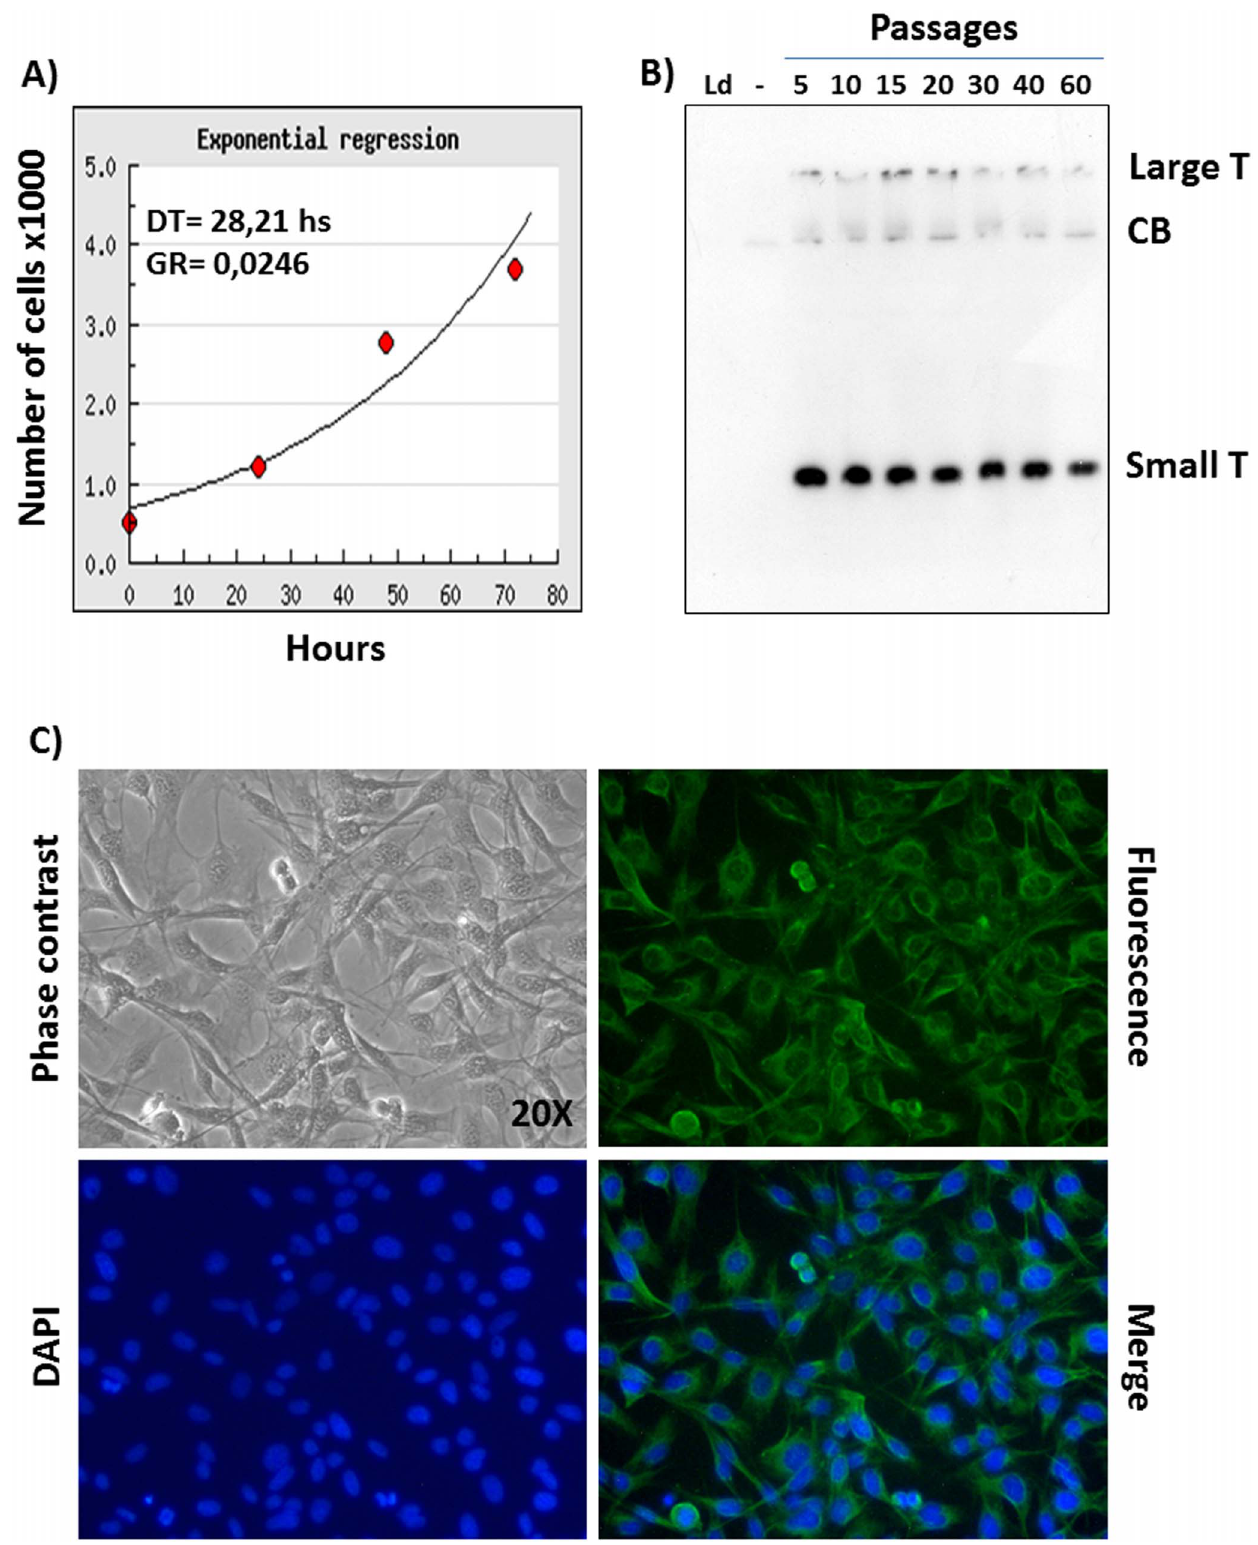
Figure 2. Cell line characterization. A) Exponential regression curve by which ASSCs doubling time (DT) and growth rate (GR) was calculated. B) SV40 large and small T antigen expression in ASSCs at different passages (5, 10, 15, 20, 30, 40 and 60) as monitored by Western immunoblotting. A cross reactive protein band (CB) is detected also in the negative control ( 2 ), ASSC primary culture. The ladder lane is indicated by Ld. C) Phase contrast and fluorescent images (20x) of ASSCs from the 60 th passage indicating expression of the stromal marker, vimentin. Counterstained nuclei with 4 9 , 6-diamidino-2-phenylindole (DAPI) were merged with green fluorescent image (merge). ASSCs from the 3 rd , 10 th , and 20 th passage stained